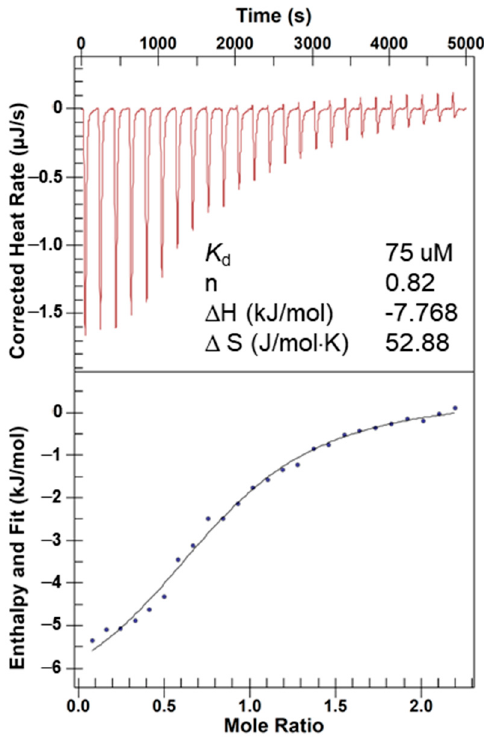
Figure 6. Measurement of binding affinity of the wAlb12 to Co(II) by isothermal titration calorimetry (ITC). The ITC analysis was performed three times and a representative titration curve was shown.